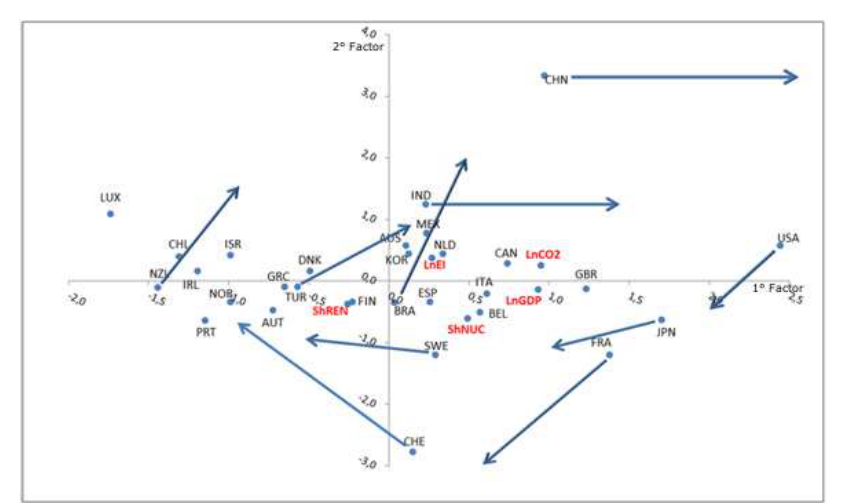
Figure 1 – Factor analysis. Distribution of countries considered in the work on the first factorial plane relative to 1980. The arrows indicate the most significant shifts observed in factorial plan of